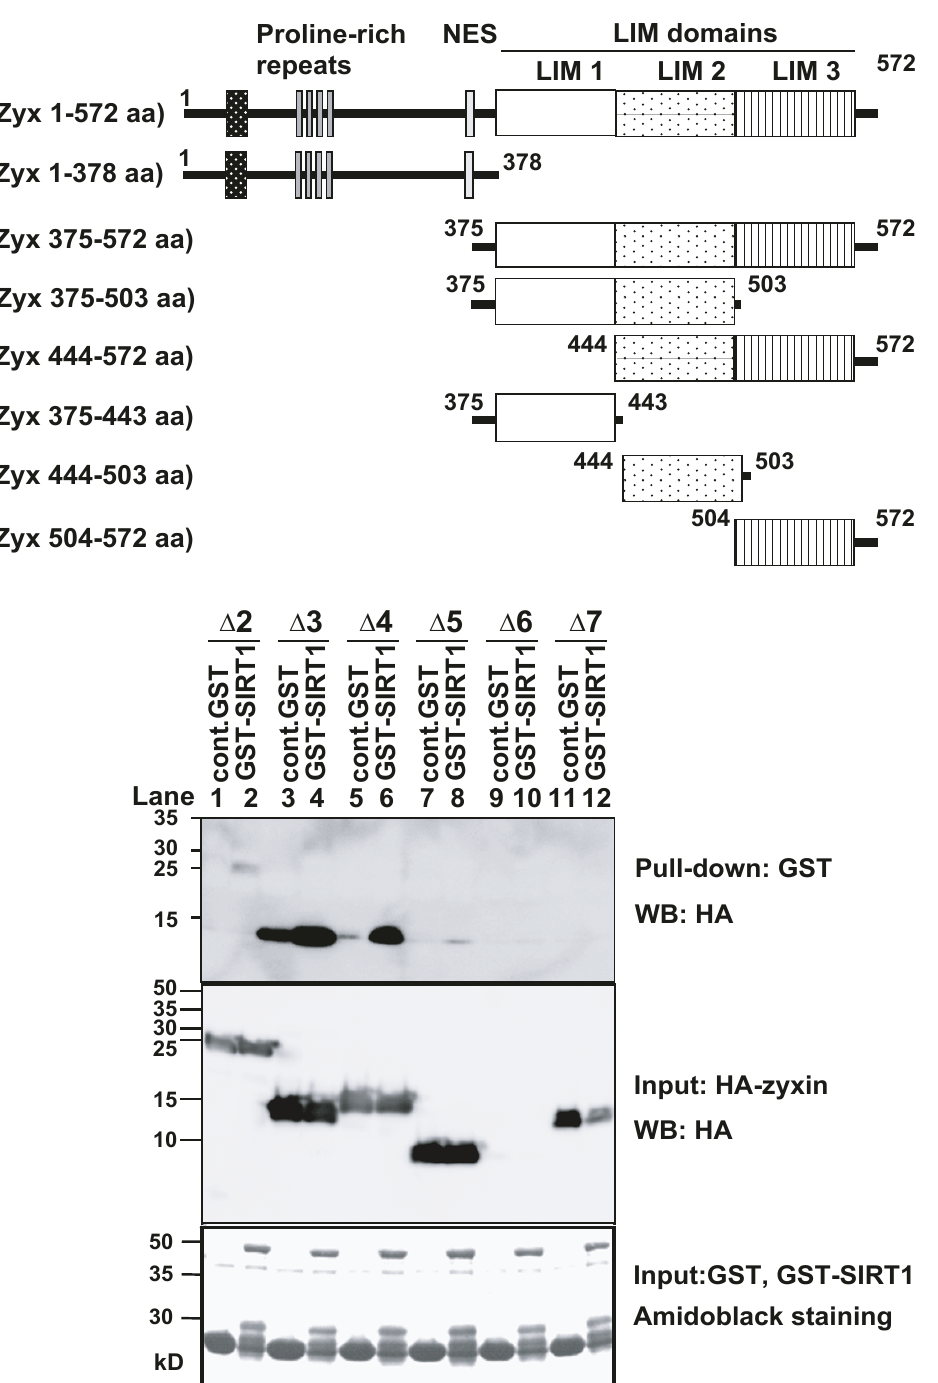
Figure 2 In vitro interaction of SIRT1 and zyxin . (A) Diagram of zyxin full length (FL) and its various deletion mutants. (B) In vitro mapping of zyxin domains associates with SIRT1. HEK293T cells expressing the indicated zyxin-deletion mutant were lysed and the resulting lysates were incubated with GST-SIRT1 or control GST proteins immobilized on glutathione sepharose beads. Bound proteins were probed with anti-HA antibody. HA-zyxin or its mutants in lysates were revealed by immunoblotting with anti-HA antibody. The amounts of GST-SIRT1 and control GST proteins were revealed by amido black